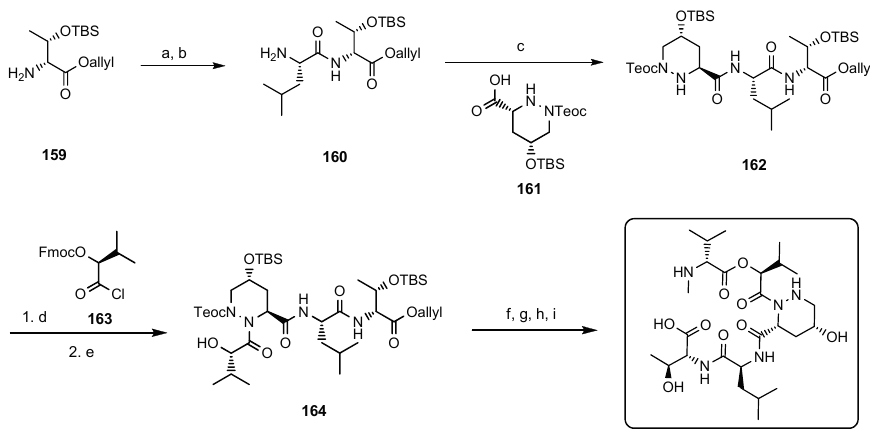
Scheme 8. Total synthesis of himastatin: fragment 165 .